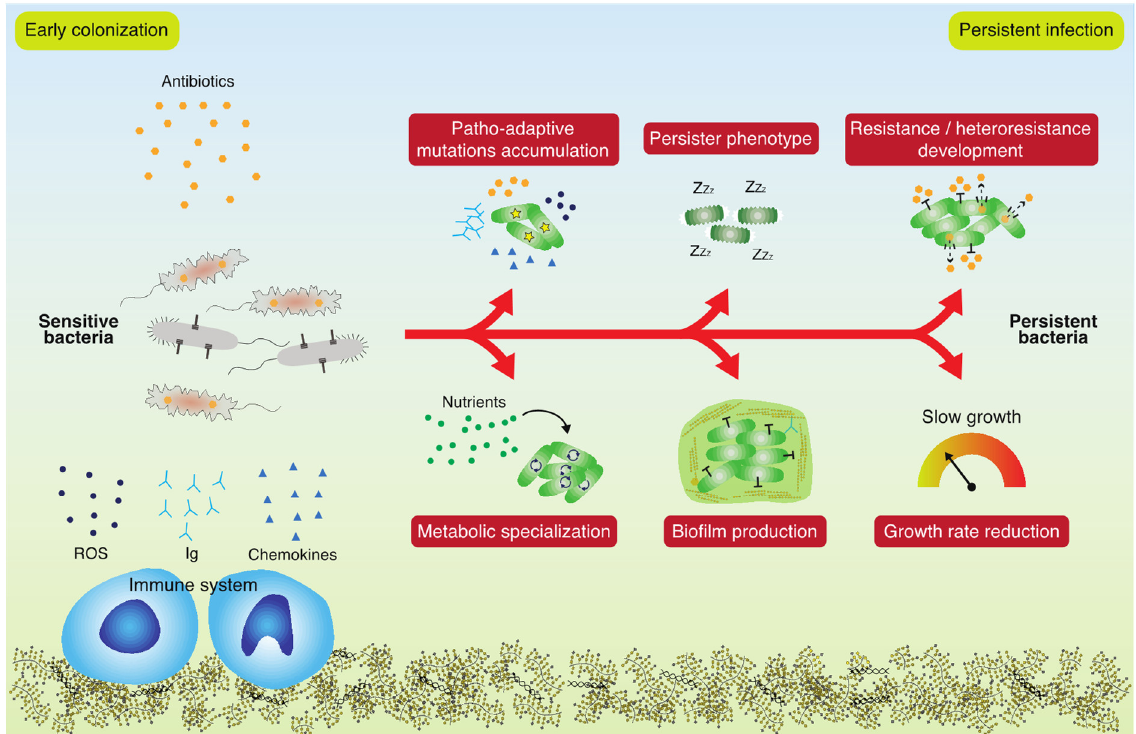
Figure 1. Bacterial adaptation during a persistent infection. Sensitive bacteria are subjected to stresses such as antibiotics and the immune system and use unconventional mechanisms to persist in the host. Patho-adaptive mutations accumulation, persister phenotype, resistance and heteroresistance development, metabolic specialization, biofilm associated lifestyle and growth rate reduction are some of the main mechanisms of adaptation leading to an untreatable persistent infection.